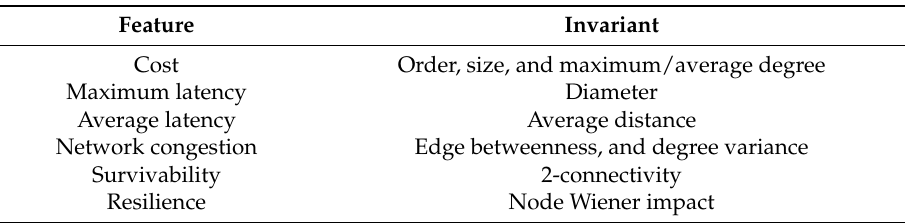
Table 1. Network requirements and